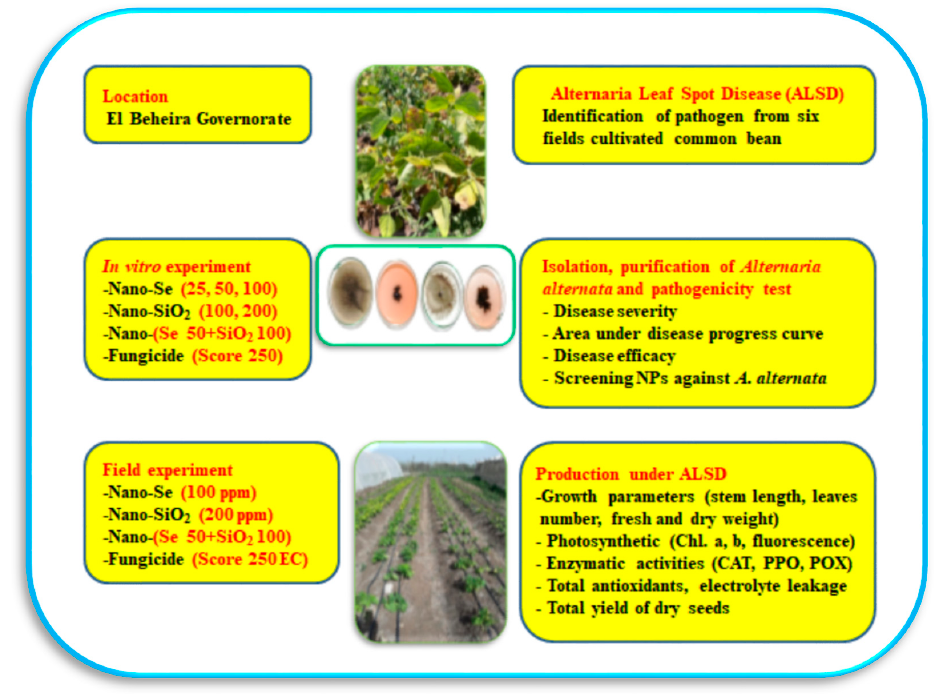
Figure 1. A general overview on the layout of the current study including the location, different experiments, and different measurements. Abbreviations: ALSD: Alternaria leaf spot disease; Chl.: chlorophyll; CAT: catalase; PPO: polyphenol oxidase; POX: peroxidase.